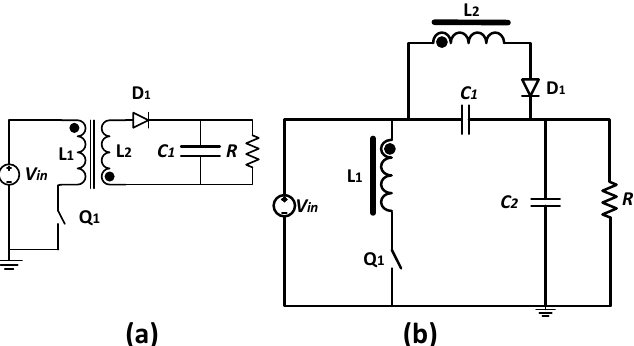
Figure 1. ( a ) Basic flyback and ( b ) modified flyback with partial energy processing.